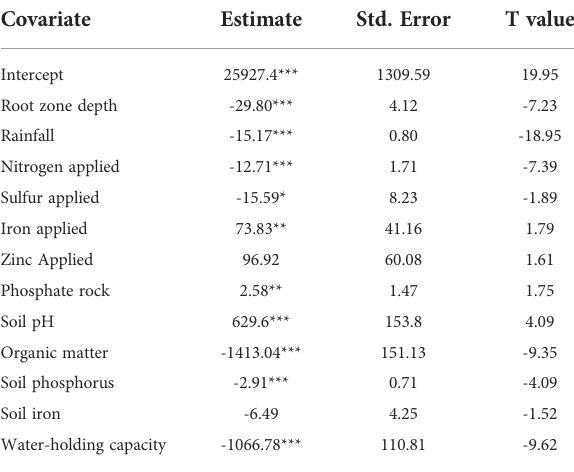
TABLE 8 Factors in fl uencing maize yield gap in the study area based on the